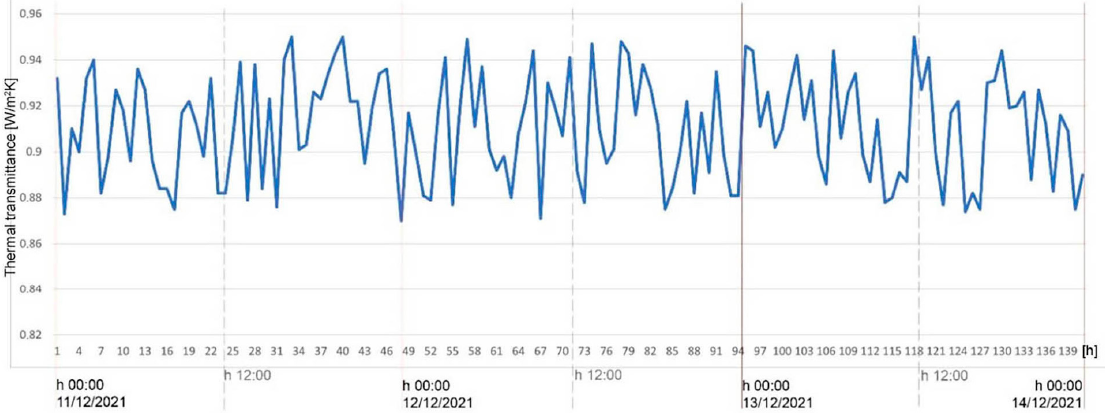
Figure 14. Tuff perimeter wall thermal transmittance diagram as a function of time: ante